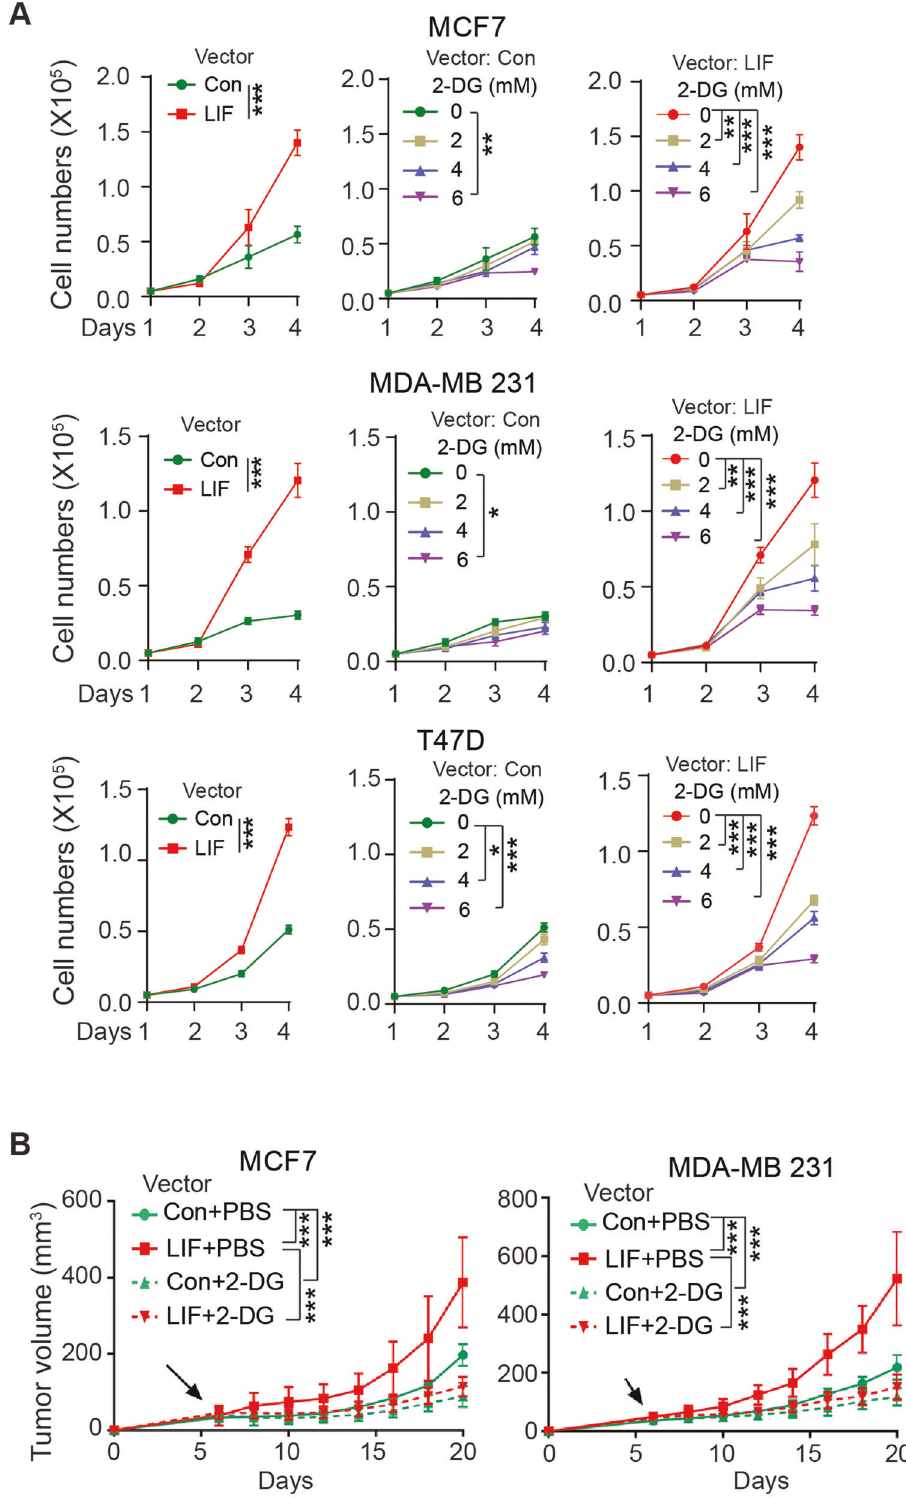
Fig. 3 2-DG, a glycolysis inhibitor, preferentially inhibits the proliferation of breast cancer cells and the growth of xenograft tumors with LIF overexpression. A 2-DG preferentially inhibited the proliferation of breast cancer cells with ectopic LIF expression compared with control cells transduced with control vectors. MCF7, MDA-MB 231, and T47D cells with or without ectopic LIF expression were treated with 2-DG at different concentrations. B 2-DG treatment exhibited a more pronounced inhibitory effect on growth of xenograft tumors formed by MCF7 and MDA-MB 231 cells with ectopic LIF expression than those formed by control cells. Mice with xenograft tumors (~50 mm 3 ) were administered with 2-DG (i.p., 1 g/kg mice, every two days for two weeks). Arrows represent the start of 2-DG treatment. Data are presented as mean ± SD. In A , n = 3/group; in B , n ≥ 5/group. * p < 0.05; ** p < 0.01; *** p < 0.001; 2-way ANOVA followed by Student ’ s t -test.